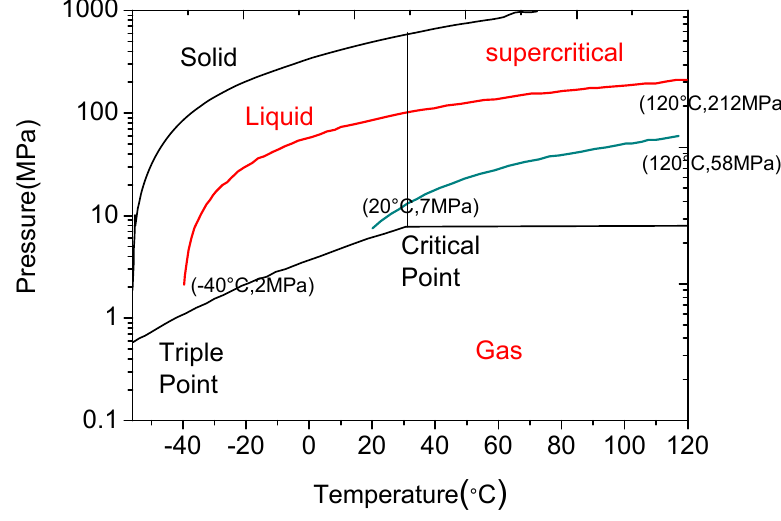
Figure 11. Isochoric process of heated CO 2 Figure 11 . Isochoric process of heated CO 2 [85].